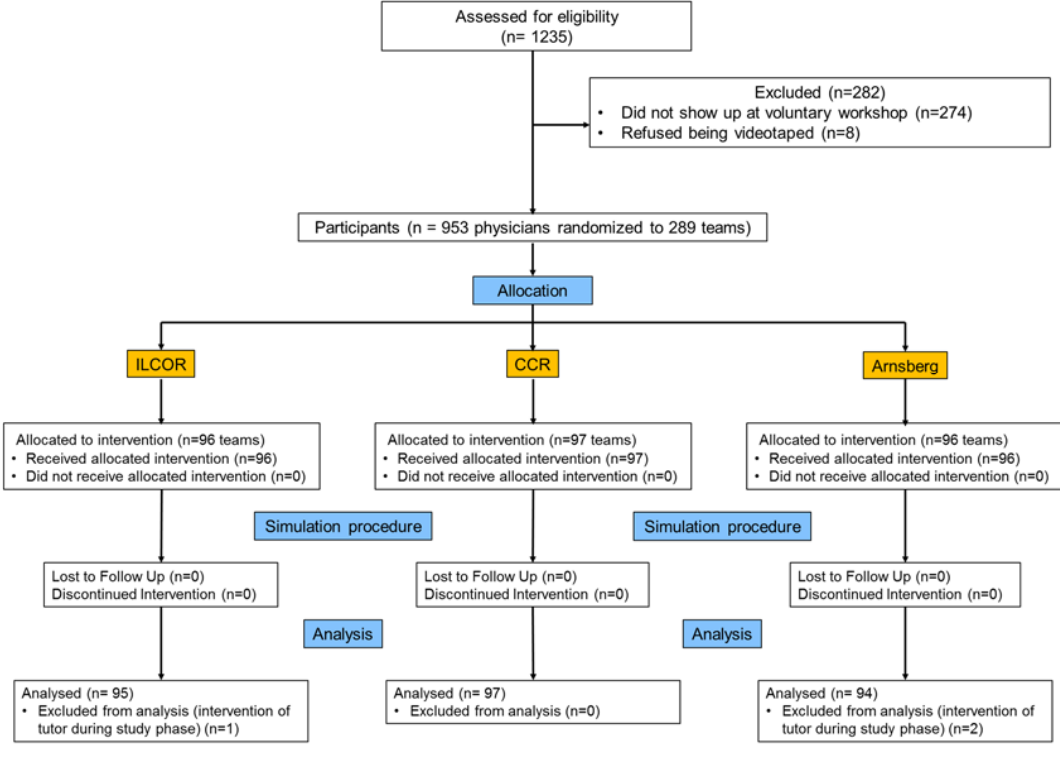
Figure 2. CONSORT flow chart.